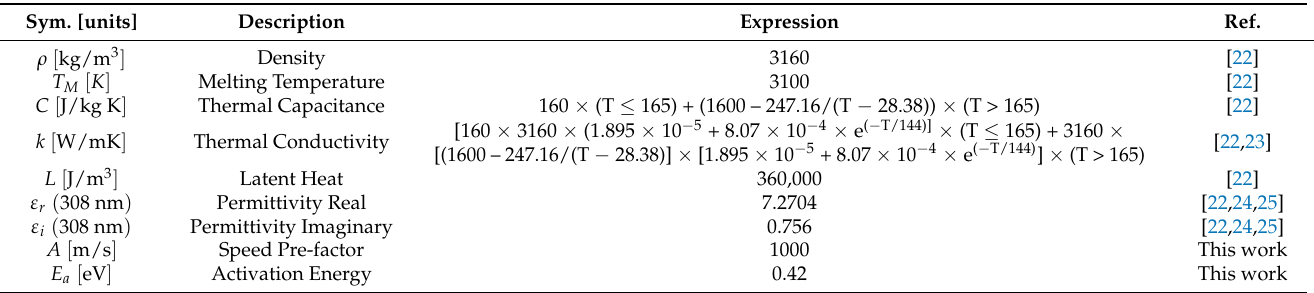
Table 3. 4H-SiC crystal material calibration parameters.